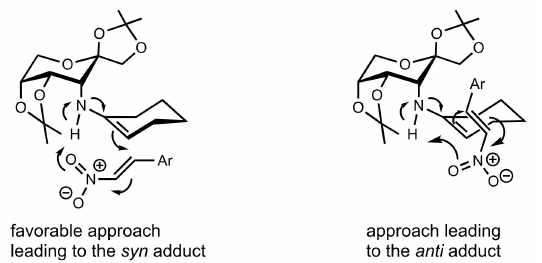
Figure 38. The proposed mechanism for the Michael additions catalysed by 516